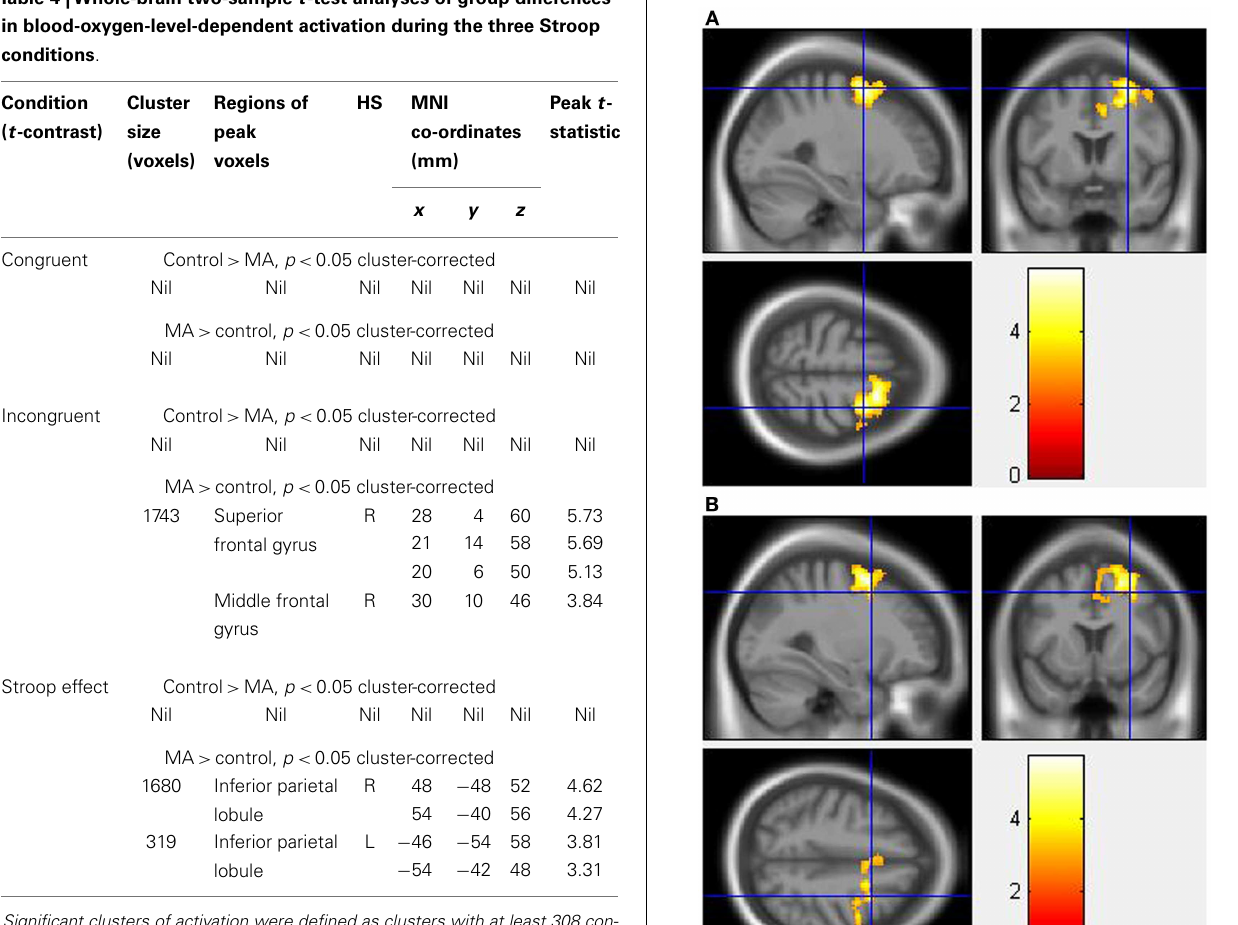
During the Stroop effect condition, the “control MPH” group showed increased activation post- compared to pre-drug administration relative to the “MA MPH” group of the left ( Figure 5A ) and right MOG ( Figure 5B ) ( p < 0.05 cluster- corrected) ( Table 5 ). No other group comparisons exhibited